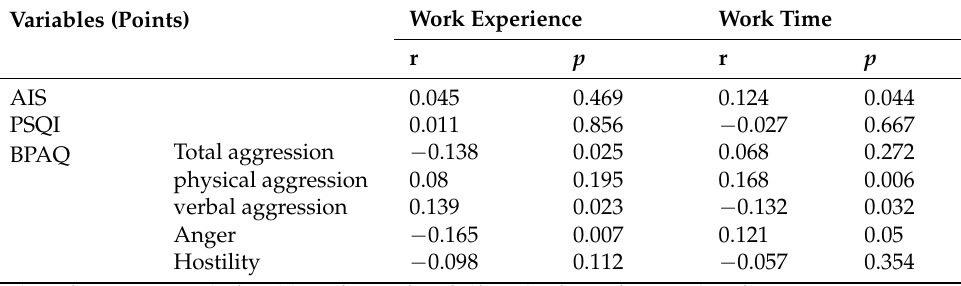
BPAQ Total aggression